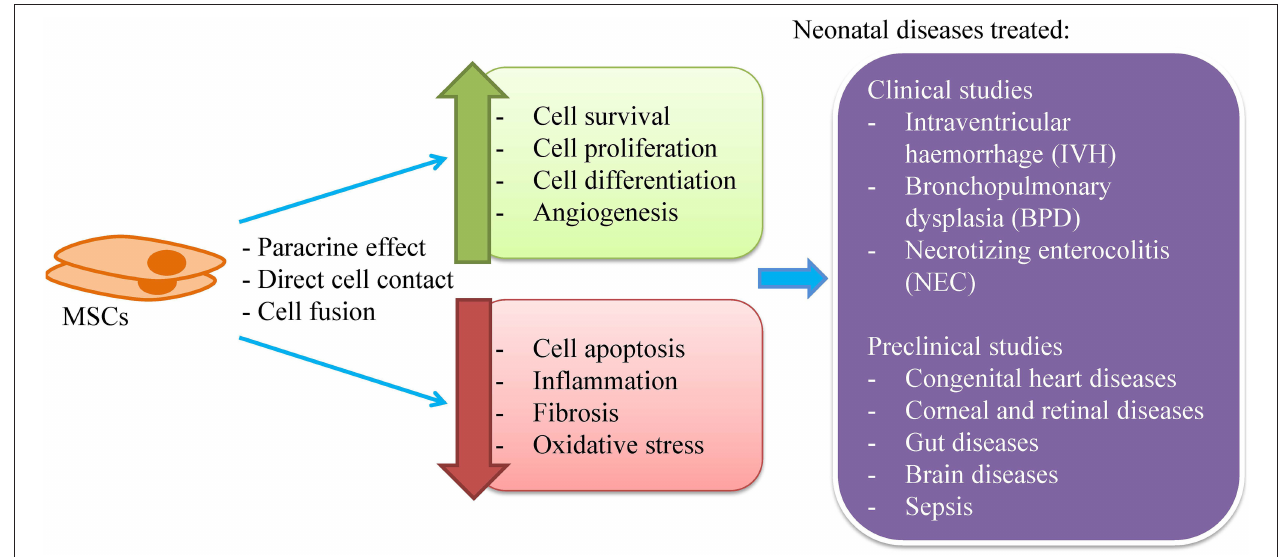
FIGURE 1 | MSCs for the treatment of neonatal diseases. MSCs are known to exert its therapeutic effect through paracrine secretion, direct cell contact and cell fusion to enhance cell survival, proliferation and differentiation, and angiogenesis as well as to reduce cell apoptosis, inflammation, fibrosis, and oxidative stress. Clinically, MSCs have been used to treat intraventricular hemorrhage, bronchopulmonary dysplasia, and necrotizing enterocolitis. Besides, MSCs have been tested for the treatment of congenital heart diseases, eye, gut, and brain diseases as well as